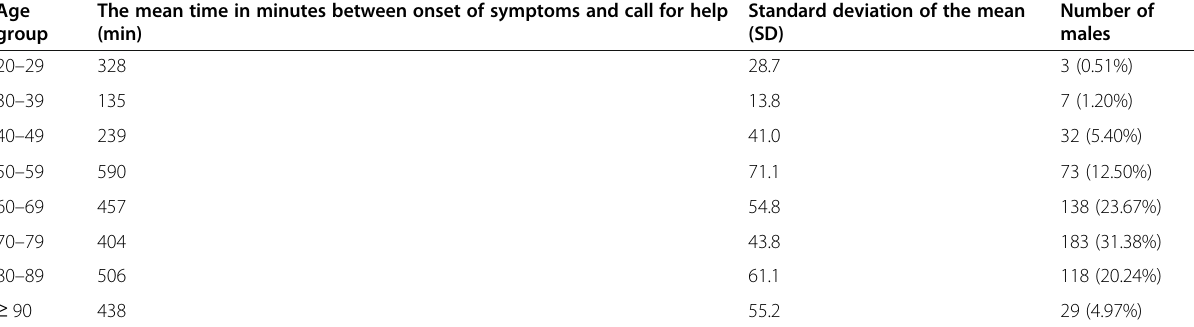
Table 2 It demonstrates time delay between symptoms onset and call for help for male patients of different age